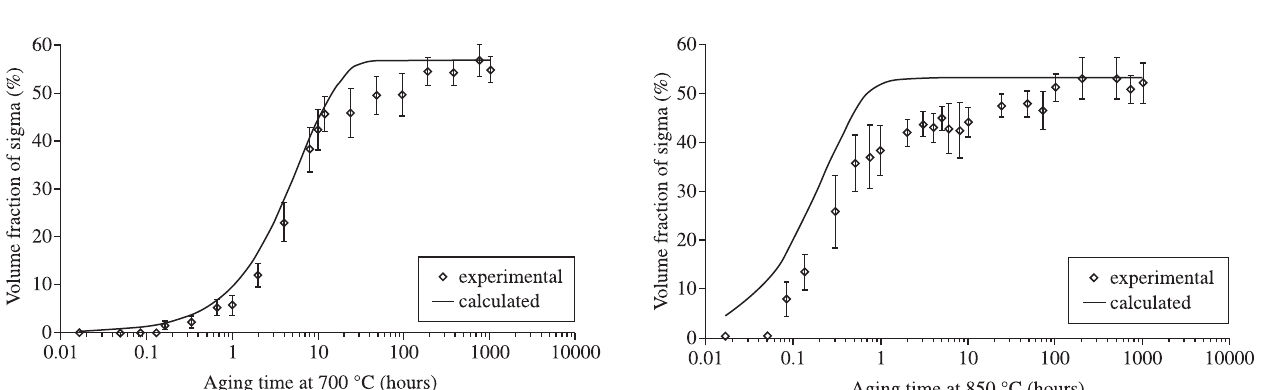
Figure 13. Experimental and calculated sigma phase content (vol. %) as a function of aging time at 700 °C.